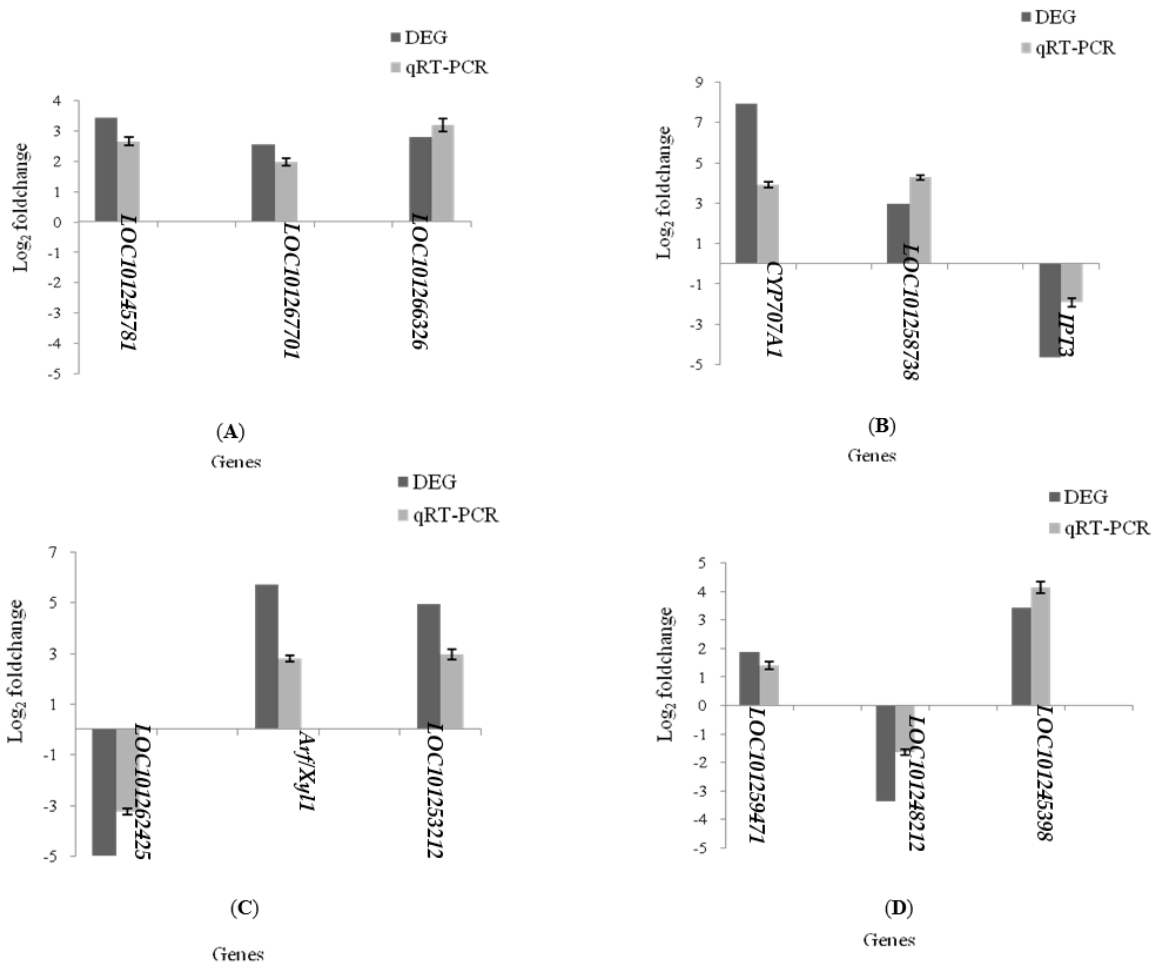
Figure 7. Quantitative real-time PCR validation of differential expression genes. ( A ), ( B ), ( C ), and ( D ) indicate the comparisons A3_1 vs. A2_1, A3_2 vs. A2_2, A2_2 vs. A1_2, and A2_1 vs. A1_1, respectively. DEG: differentially expressed gene; qRT-PCR: quantitative real-time PCR.